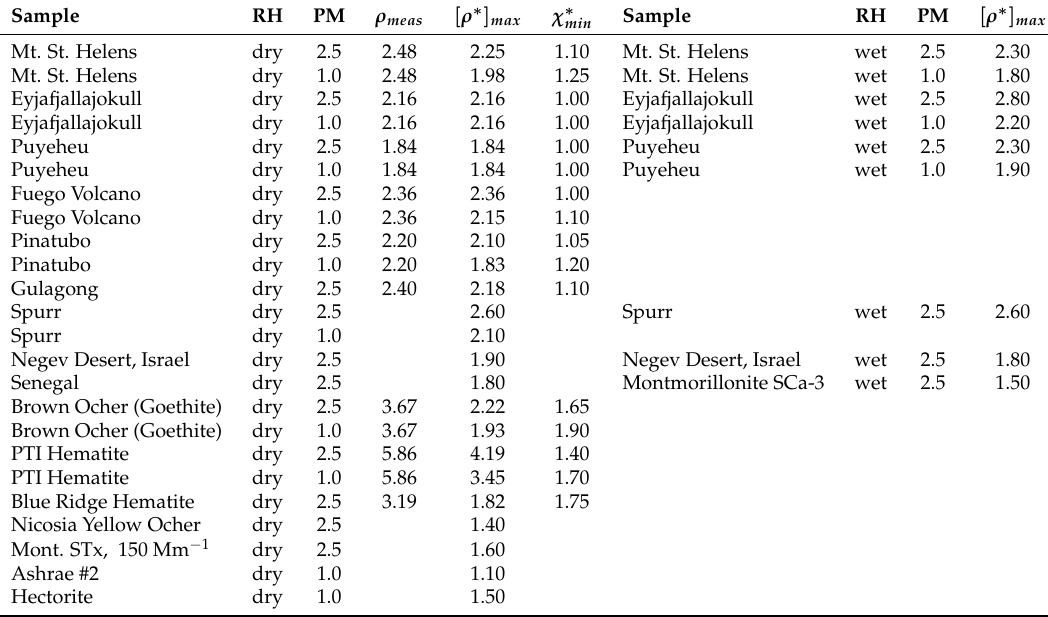
Table 4. Bulk densities ( ρ meas , g-cm − 3 ) measured using the densimetry technique and corresponding minimum dynamic shape factors ( χ ∗ ) required to produce Mie theory extinctions from aerodynamic min particle size for several of the tested samples with two different size cuts (PM 1 or PM 2.5 ). Dried samples are presented in the left columns and samples humidified to 80+% are provided in the right column. Maximum ρ ∗ (defined as ρ ∗ = [ ρ / χ ∗ ] , g-cm − 3 ) that produce Mie theory extinctions from aerodynamic particle size are also shown. GRASP residuals for all samples are ≤ 8%, except for Brown Ocher and the hematites. Sample RH PM ρ meas Mt. St.